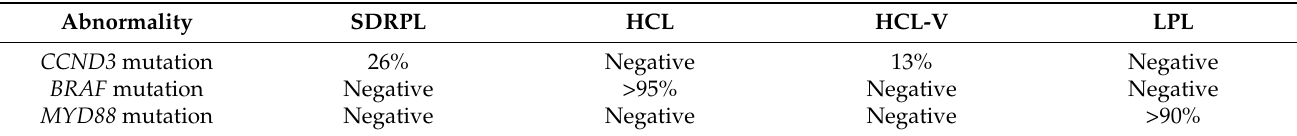
Table 5. Comparison of CCND3 , BRAF , and MYD88